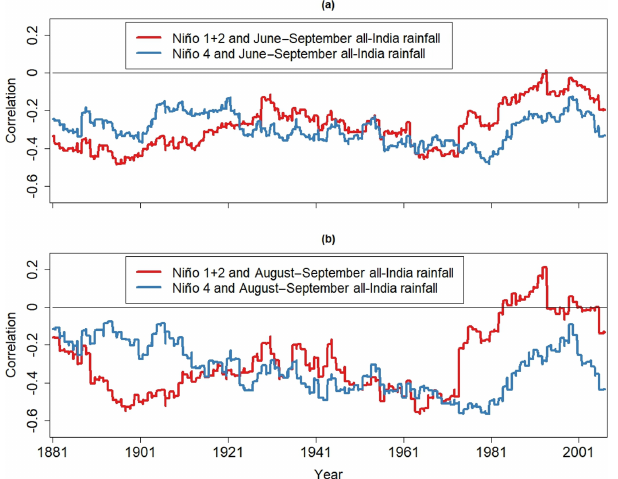
Figure 5. The 20-year sliding correlation between anomalies for June–September AIR, and the time series for the June–September Niño 1 and 2 and Niño 4 indices. (b) Same as (a) but for the August– September season.